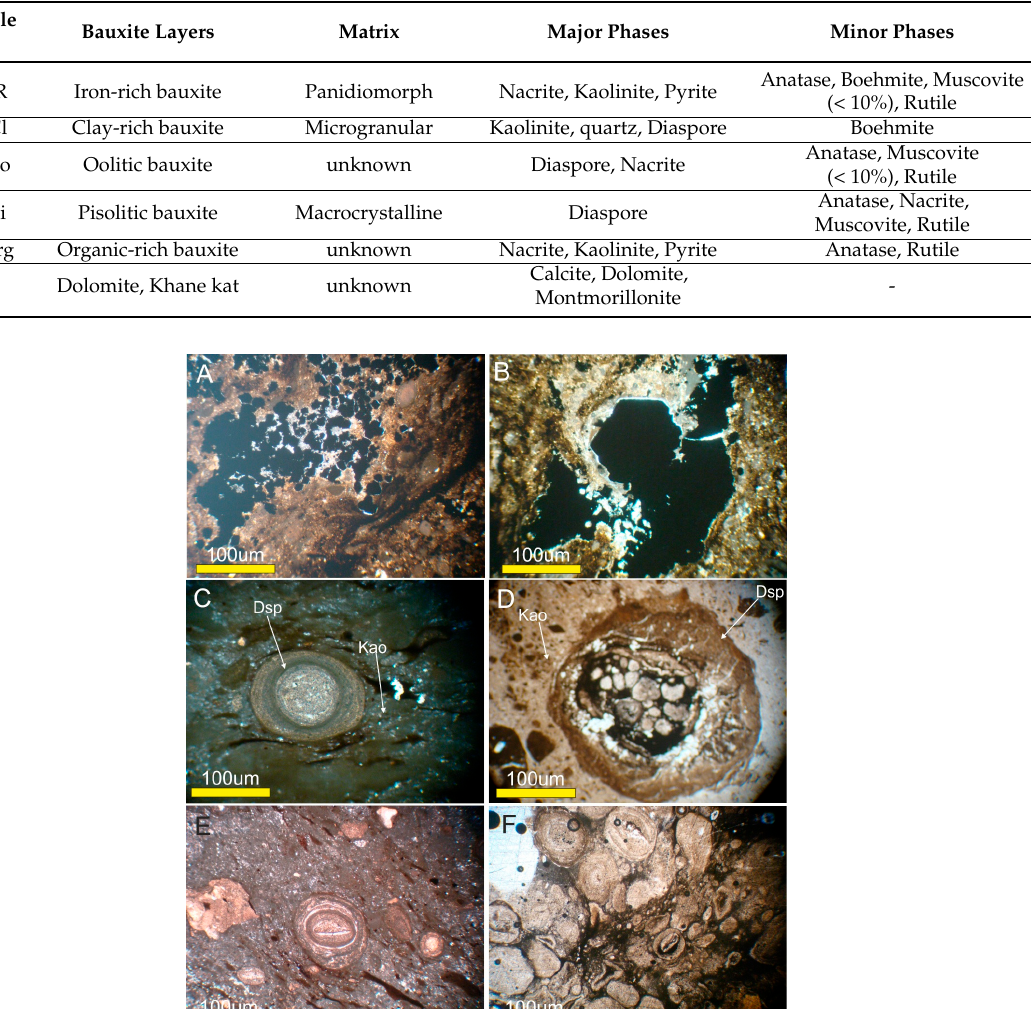
Table 1. X-Ray diffraction (XRD) mineralogical results and textural characteristics of selected samples of the Dopolan deposit.